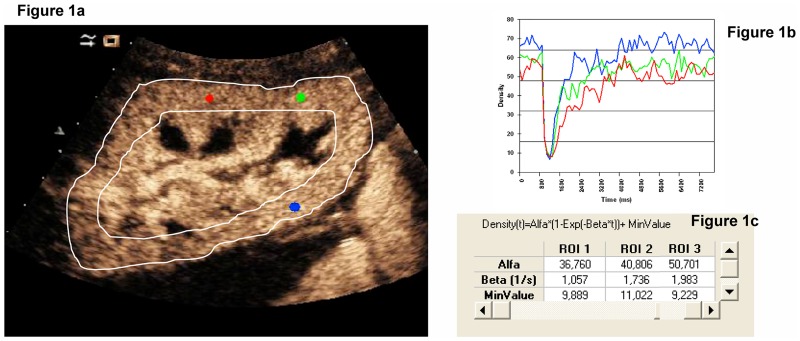
This figure shows renal graft perfusion by contrast media in a longitudinal view.Red, green and blue circles are regions of interest selected in the proximal and distal renal cortex. The white line identifies and isolates the renal cortex. Once uniform graft perfusion was achieved, microbubbles were destroyed with a high mechanic ultrasound pulse. The replenishment kinetics was recorded stored in order to perform time-intensity curves using a software tool (Fig 1b). Cortical capillary blood flow for each region of interest could be estimated (Fig 1c).